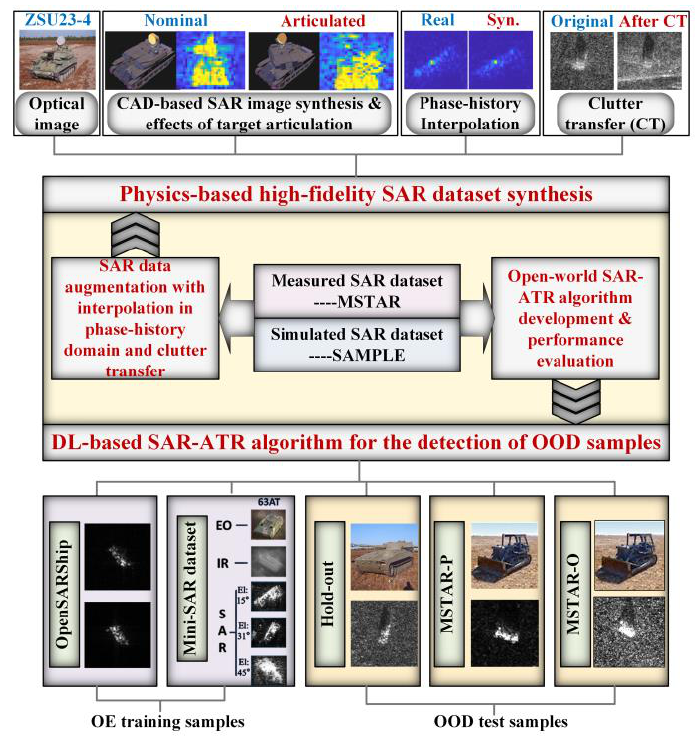
Figure 2. Structure of this